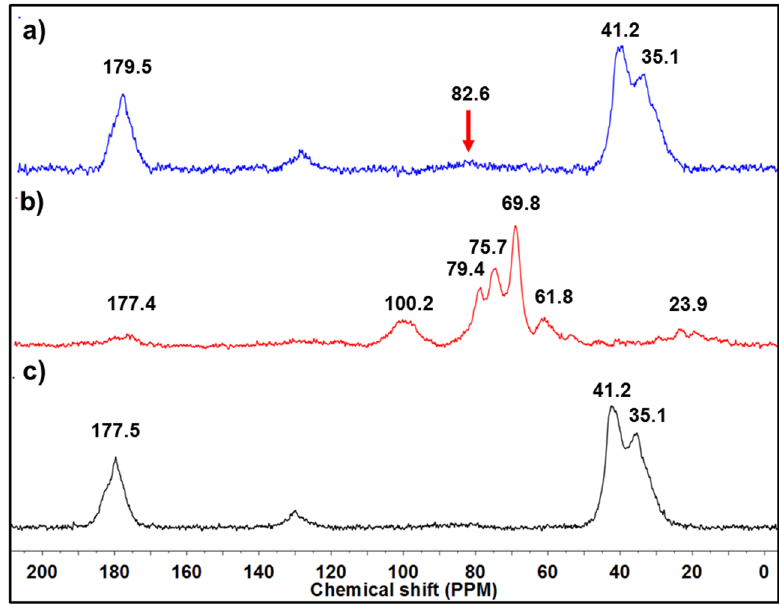
Figure 3. 13 C-NMR spectra of ( a ) hydrogel, ( b ) agar, and ( c )